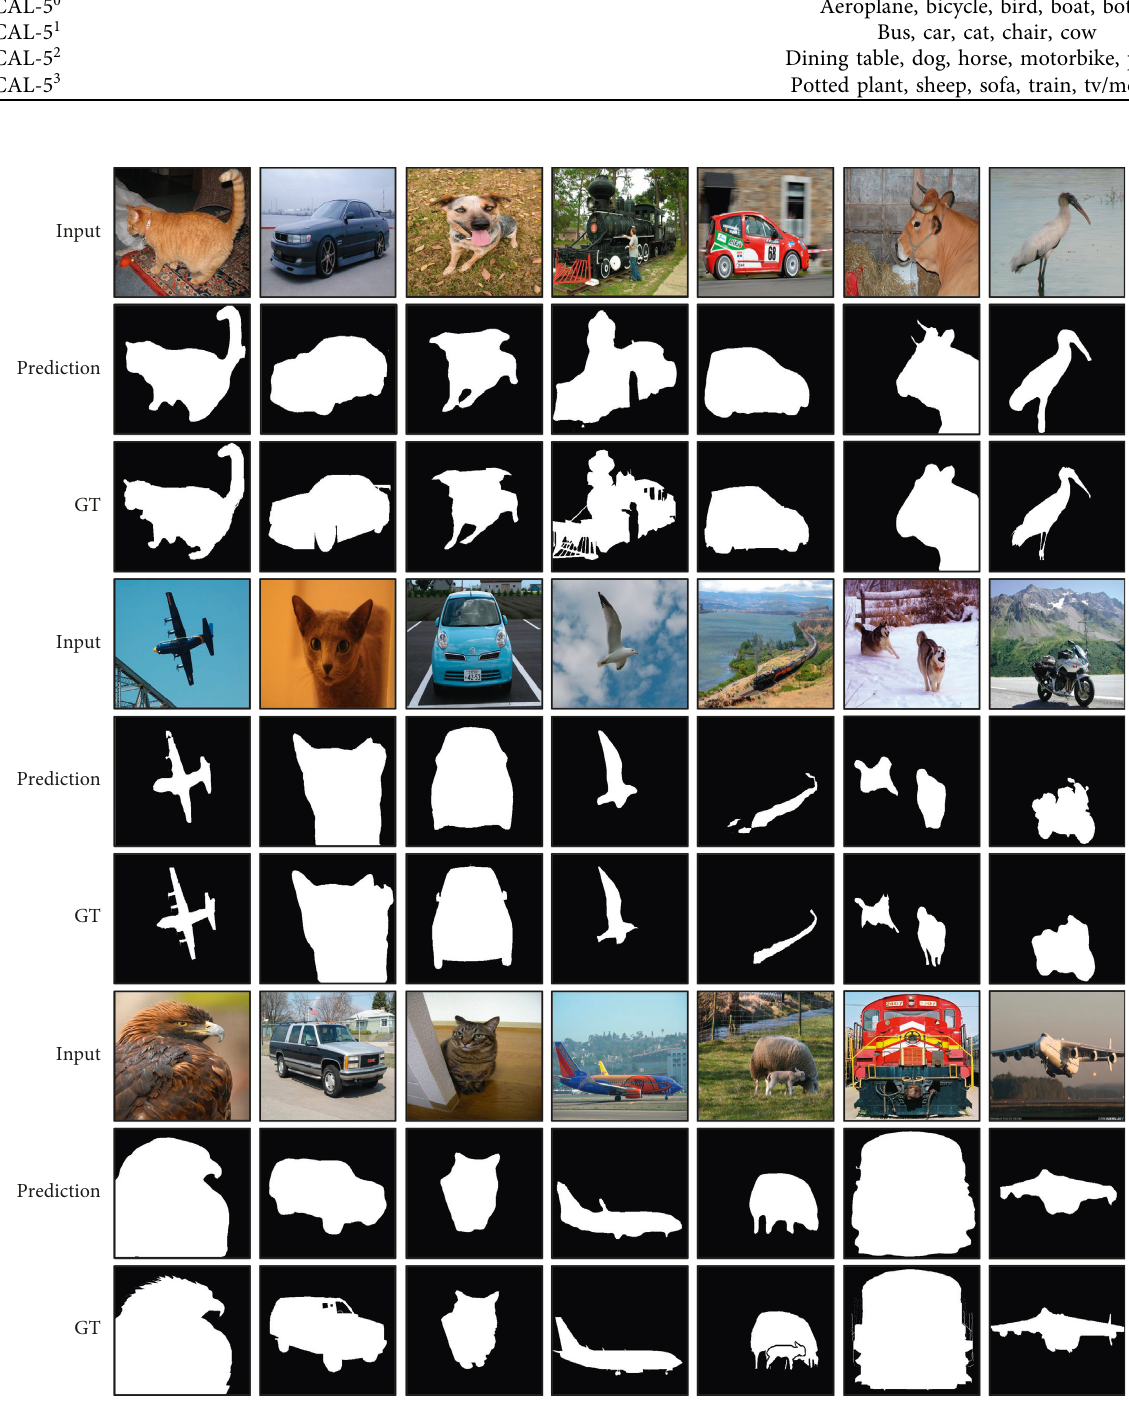
Figure 2: The segmentation results by the proposed method.